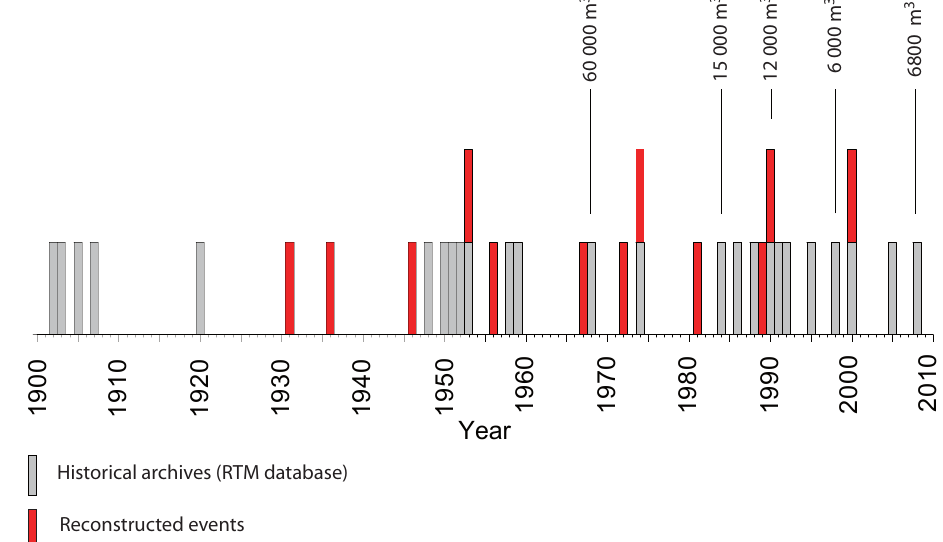
Fig. 8. Comparison of debris-flow frequency as documented from historical archives and with the reconstructed time series obtained with dendrogeomorphic methods at